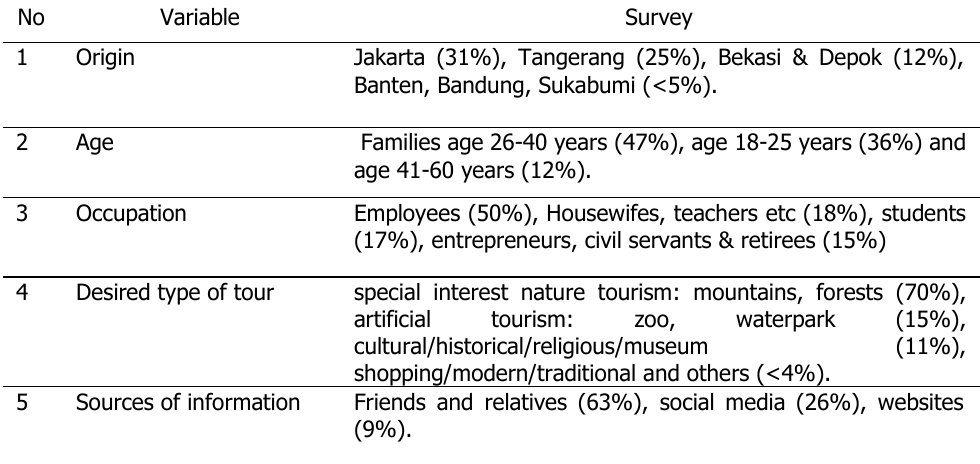
Table 1. Infographics and Preferences of Domestic Tourists to Bogor